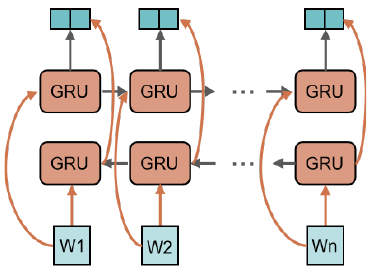
Figure 5. BiGRU structure.